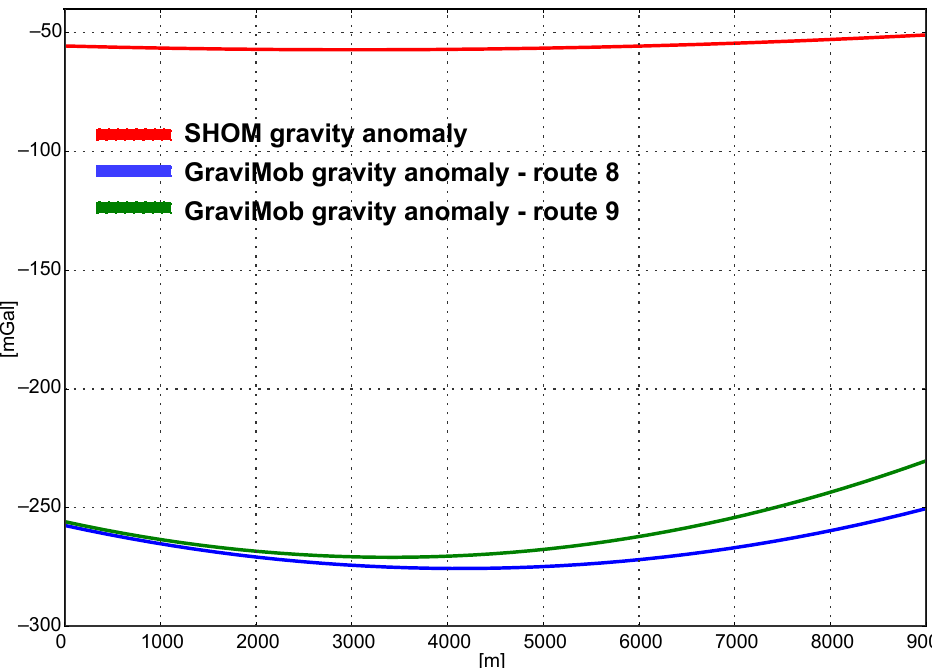
Figure 14. Variations of gravity anomaly trends deduced from SHOM (red solid curve) and GraviMob measurements on routes 8 (blue solid curve) and 9 (green solid curve). These trends were obtained by fitting second degree